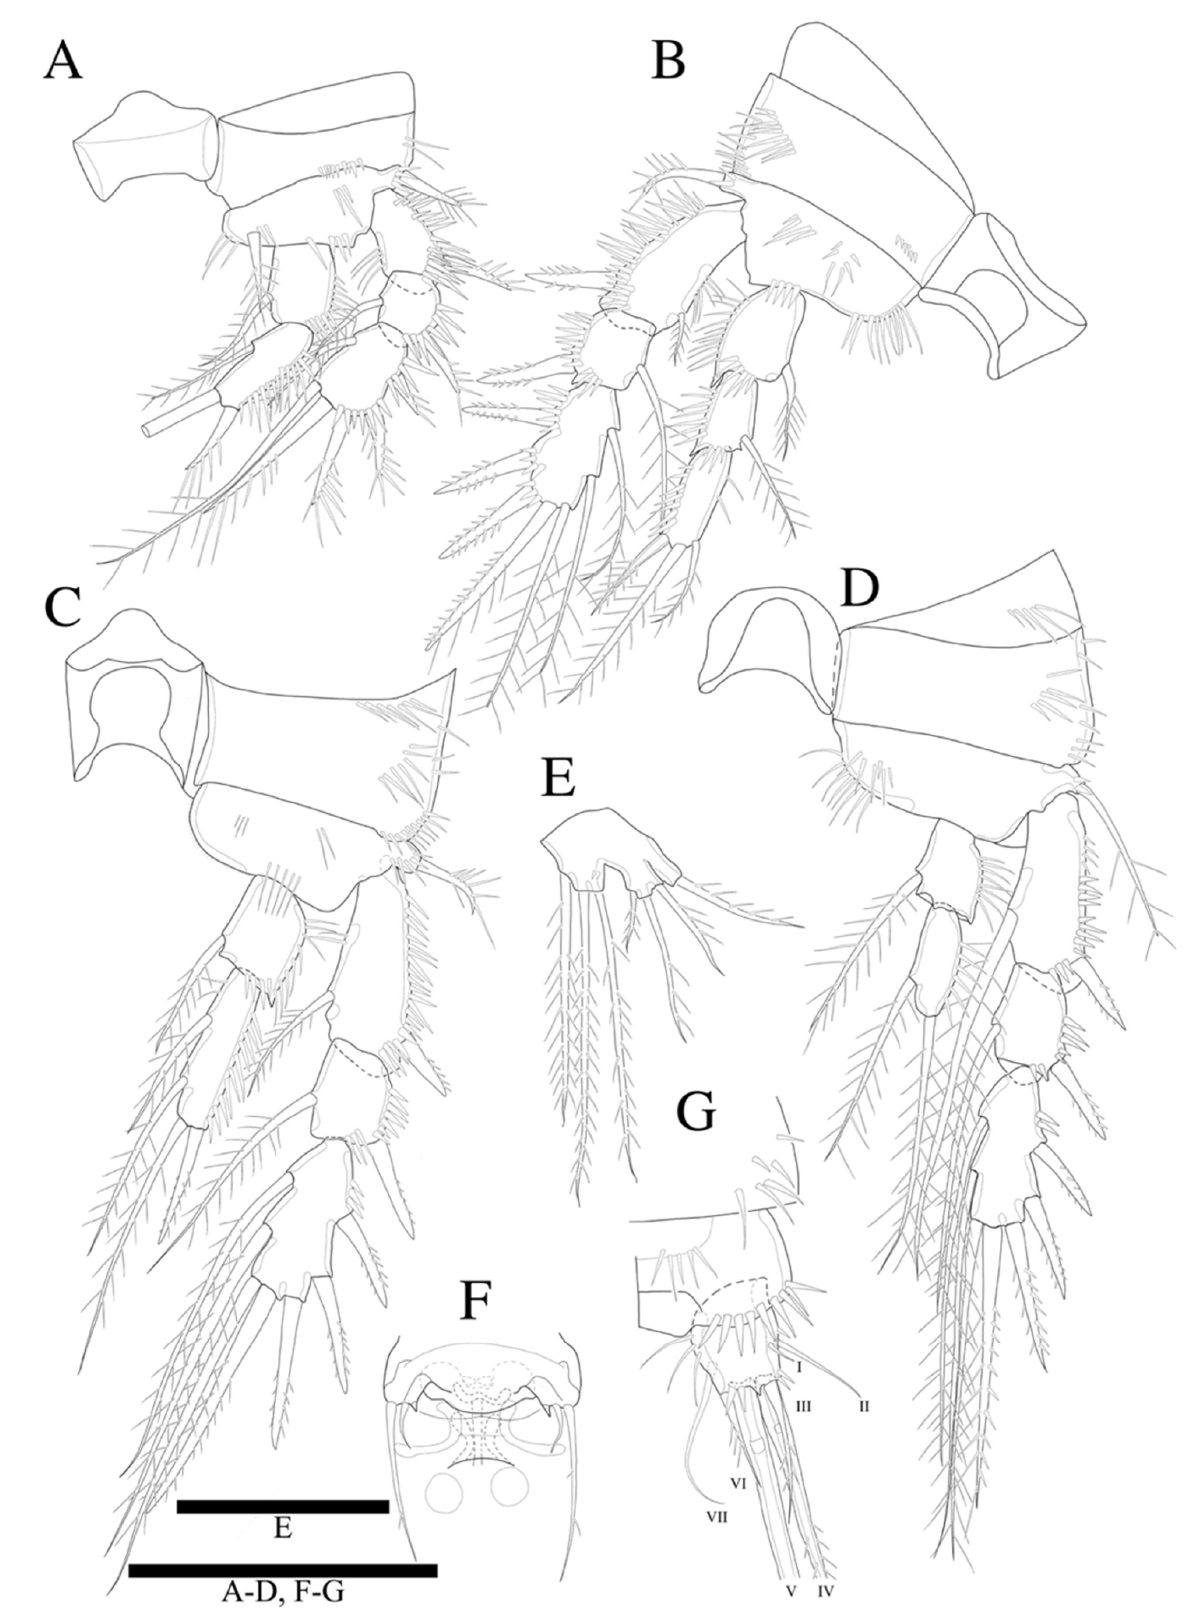
Figure 12. Peresime pryorae sp. nov. ( A ) P1; ( B ) P2; ( C ) P3; ( D ) P4; ( E ) P5; ( F ) P6; ( G ) Caudal ramus. Scale bars: 50 µm.